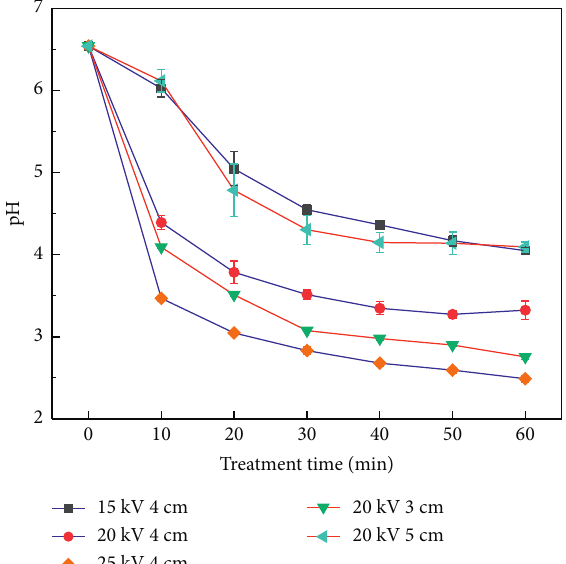
Figure 8: The needle-dielectric plate distance of 4cm and pH at voltages of 15, 20, and 25kV and the needle-dielectric plate distance of 3 and 5cm and pH at a voltage of 20 kV.